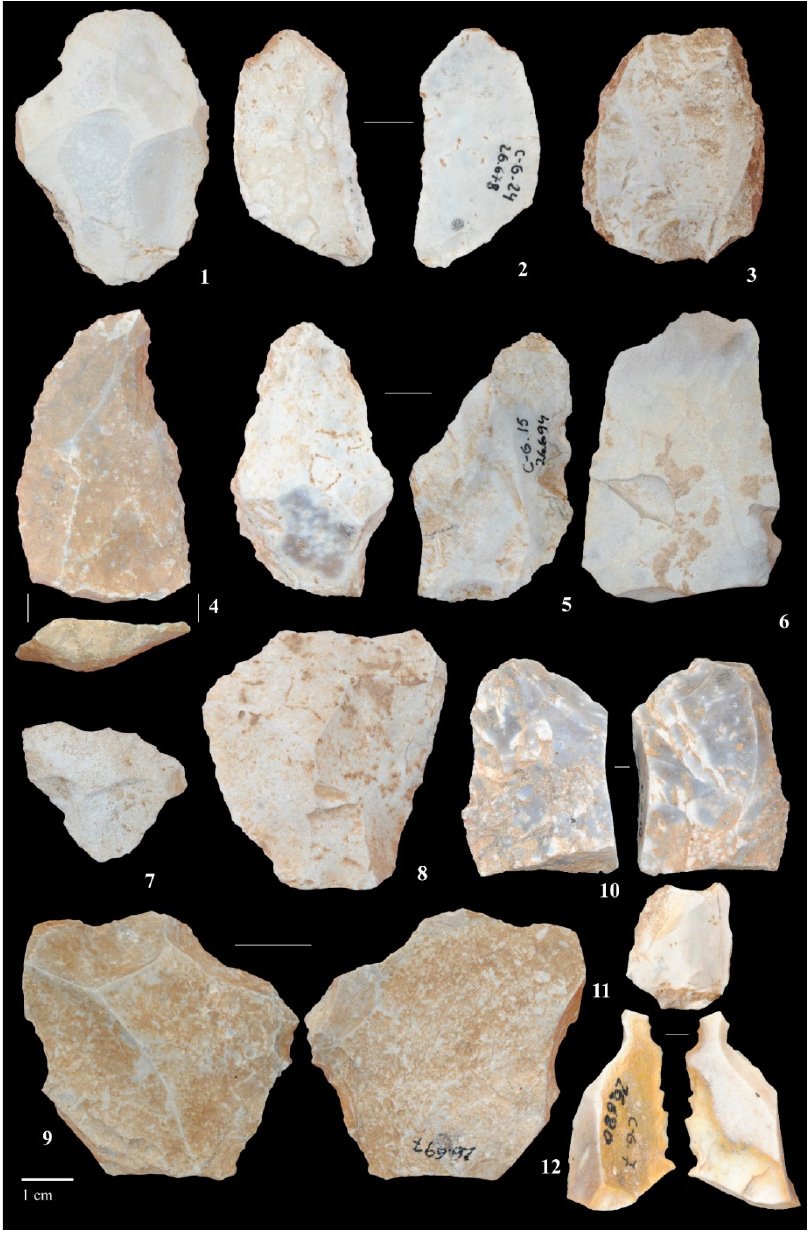
Figure 8. Lithic artifacts from Cova del Gegant. ( 1 , 3 , 11 ): Flake. ( 2 , 5 , 8 ): Sidescraper. ( 4 ): Point. ( 6 ): Levallois flake. ( 7 ): Pseudo-Levallois point. ( 9 , 12 ): Denticulate. ( 10 ): Core-on-flake.